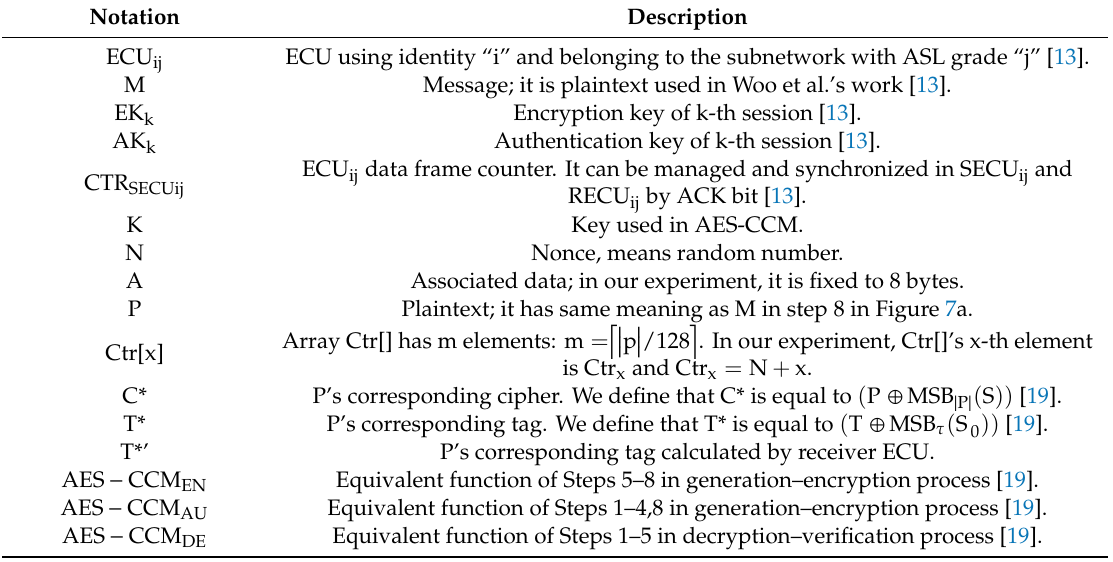
Figure 7. Original steps by previous researcher ( a ) and steps using the AES-CCM algorithm ( b ). Table 7. Notation used in steps in Figure 7.